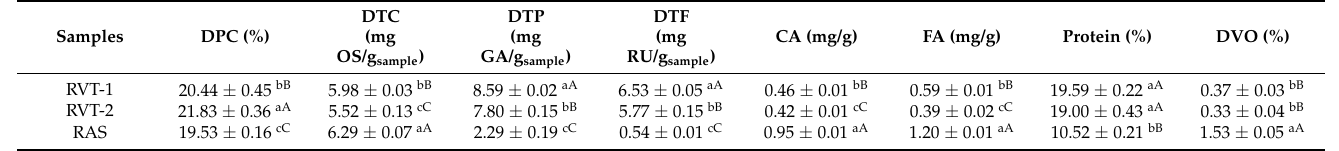
Table 1. Polysaccharide (DPC), total Coumarins (DTC), total phenol (DTP), total flavonoid (DTF), chlorogenic acid (CA), ferulic acid (FA), protein and volatile oil (DVO) contents.